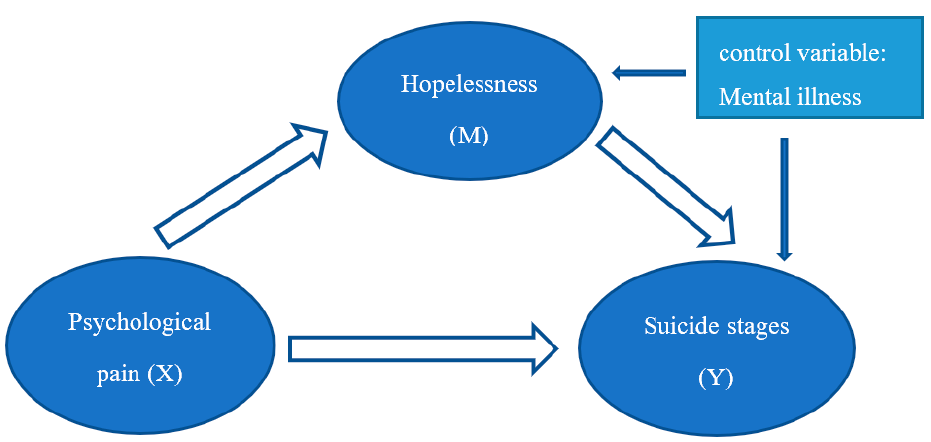
Figure 1. The mediation effect path model.